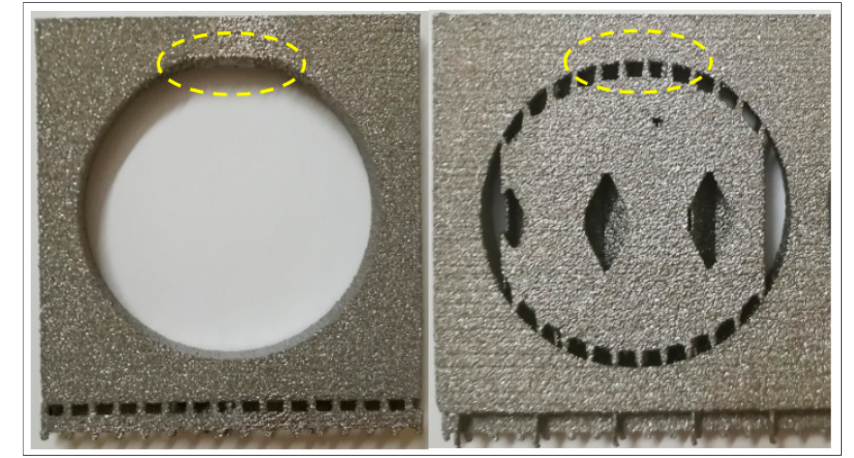
Figure 13. Hole without and with support structure.